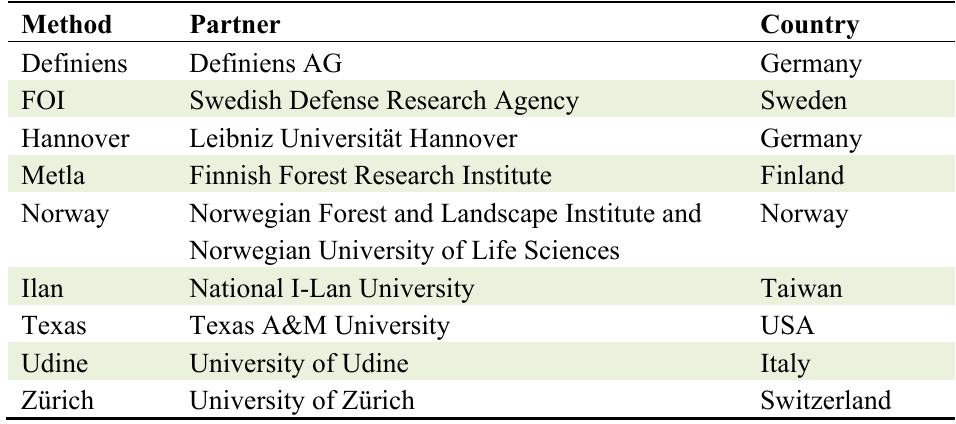
Table 3. Method names and